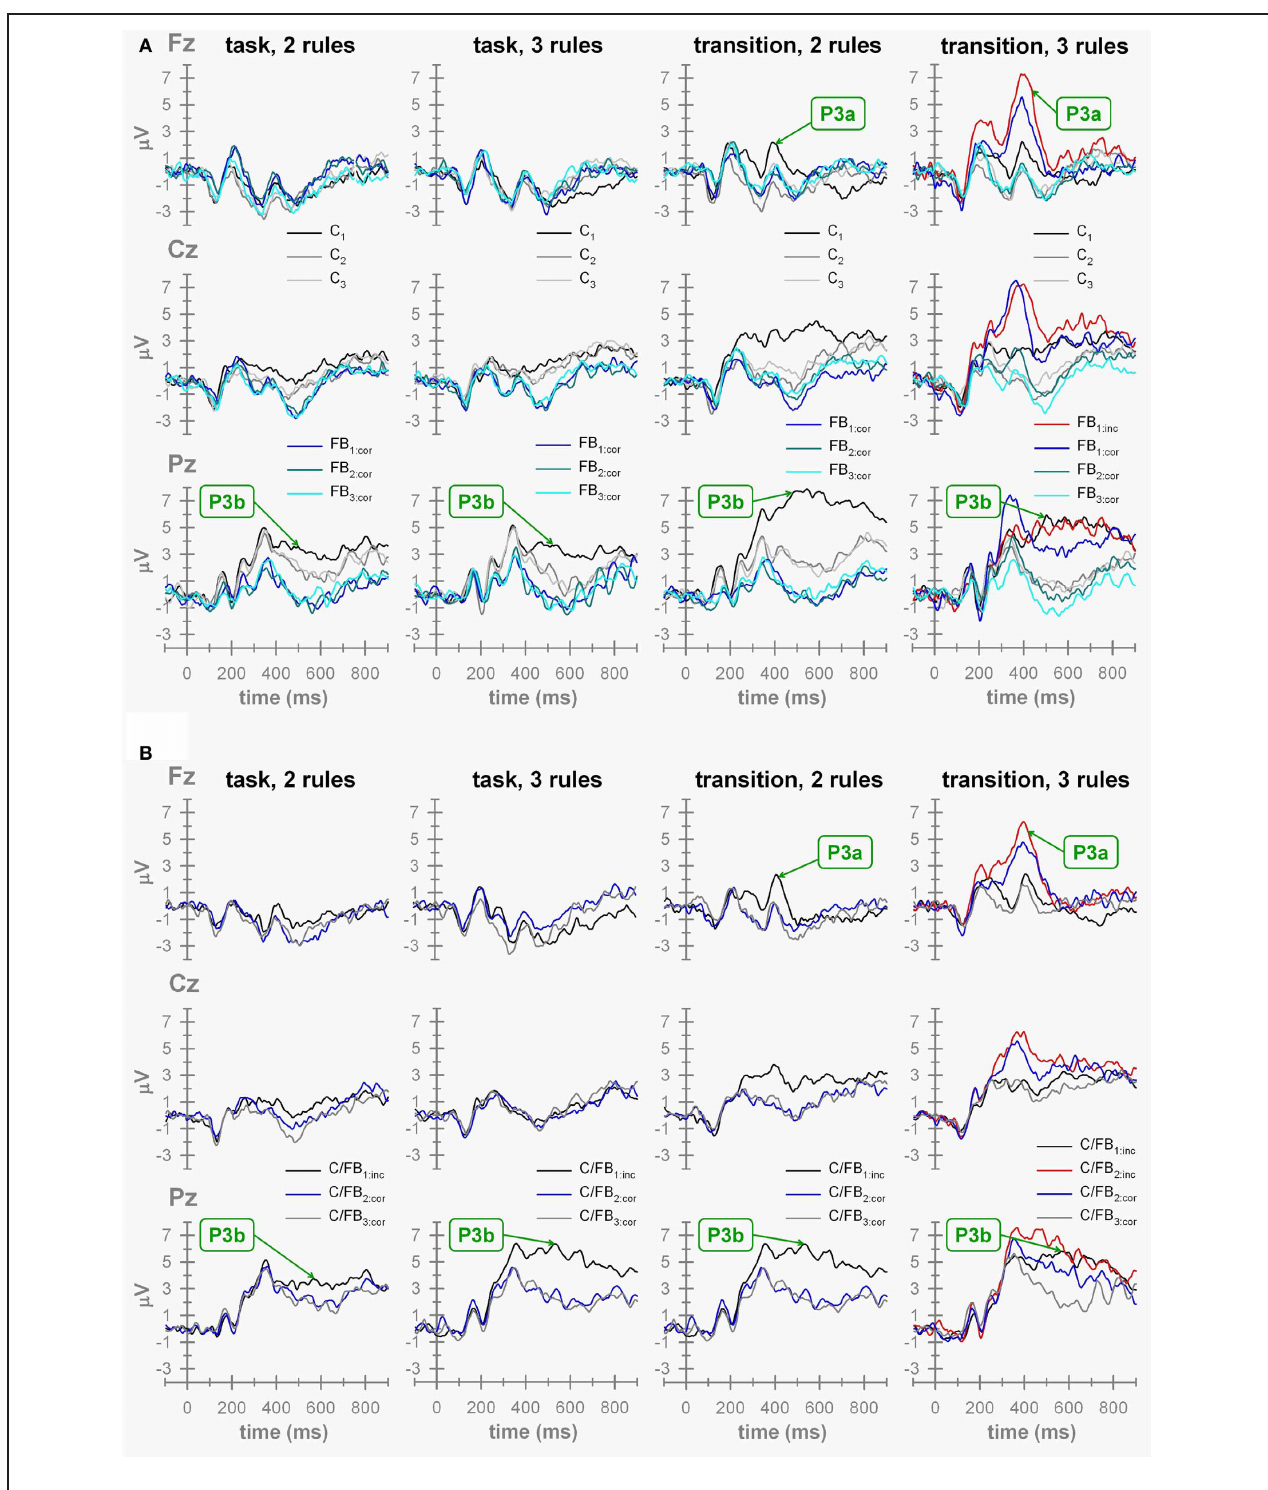
feedback stimulus on trial 1. (B) ERPs waveforms obtained on F-B cuing conditions. “task,” task-cuing conditions (two-task, three-task conditions) with C/FB x , hybrid cue/feedback stimulus on trial x { x = 1 ... 3; “cor,” correct; “inc,” incorrect}. “transition,” transition-cuing conditions (two-task, three-task conditions) with C/FB x , hybrid cue/feedback stimulus on trial x { x = 1 ... 3; “cor,” correct; “inc,”